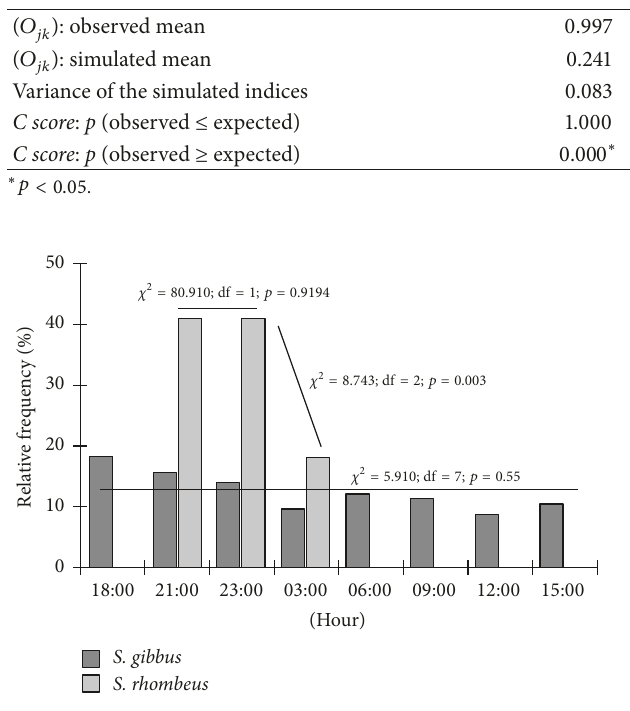
Figure 7: Seasonal variation in niche breadth in S. gibbus and S. rhombeus intheCoaracyNunesreservoirinFerreiraGomes,Amap´a